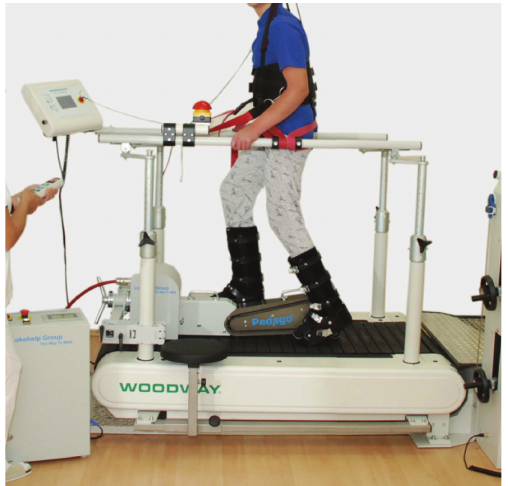
Figure 3: LokoHelp gait trainer “Pedago” (picture courtesy of LokoHelp Group).